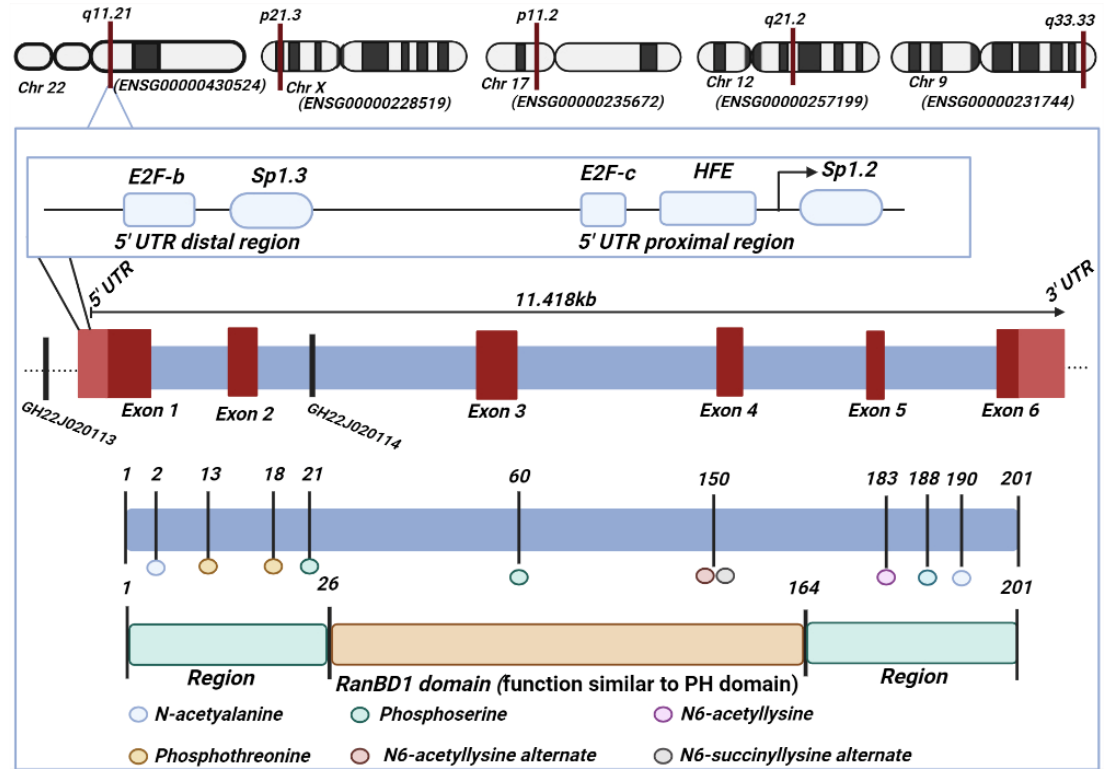
Figure 1. Structure of RANBP1. Gene’s chromosomal localization, related transcript, protein/domain and post ‐ translational modifications. Schematic representation.